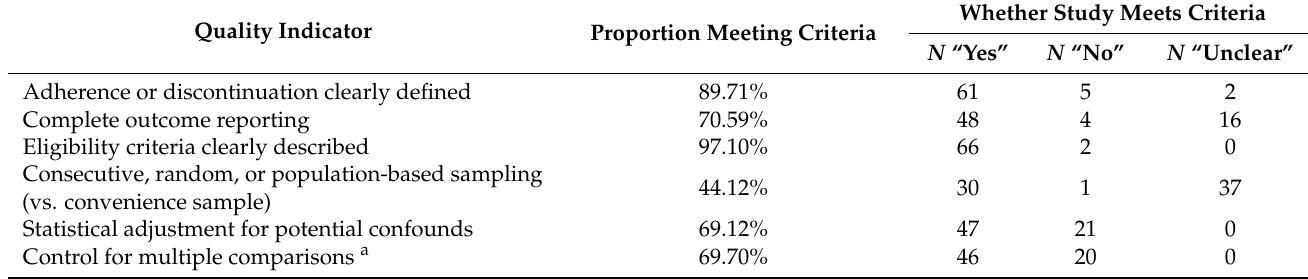
Table 2. Summary of quality indicators for all studies ( N = 68).